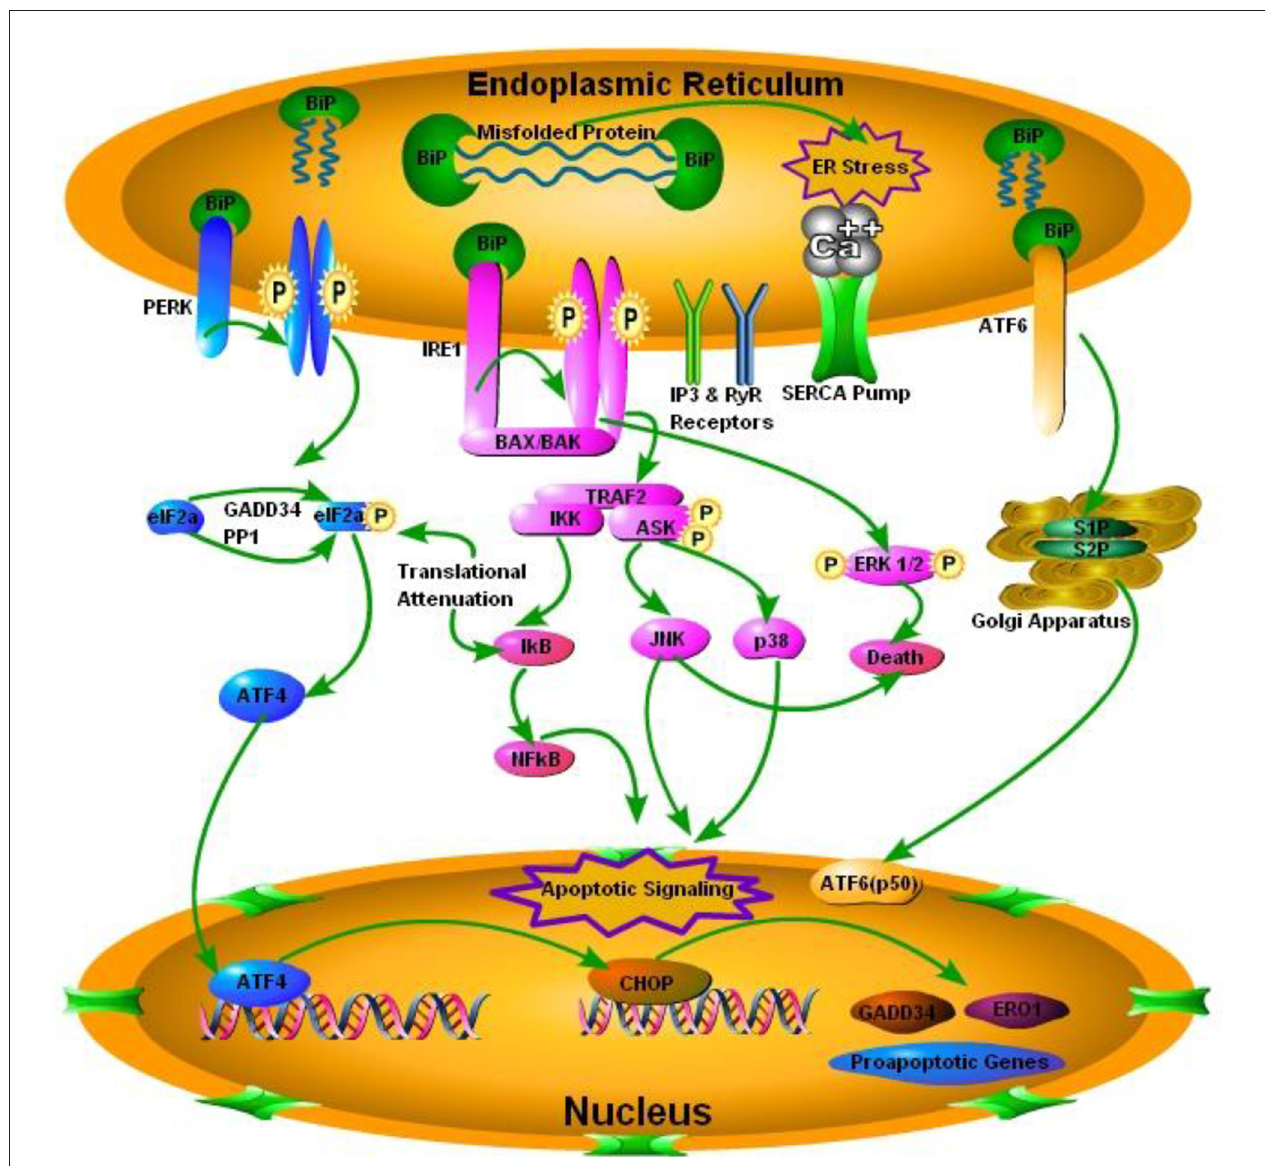
FIGURE 1 | Schematic presentation of the prion protein scrapie (PrP Sc ) accumulation and subsequent endoplasmic reticulum (ER) stress mediated activation of the iinositol requiring enzyme 1 (IRE1), double stranded RNA-activated protein kinase (PKR)-like ER kinase (PERK) and activating transcription factor 6 (ATF6). PERK pathway, through PERK phosphorylation and translation of initiation factor 2 (eIF2 α ) phosphorylation, inactivates eIF2 α and attenuates translation via activating transcription factor 4 (ATF4), which ultimately results in activation of C/EBP homologous protein (CHOP) and pro-apototic, growth arrest and DNA damage-inducible protein 34 (GADD34) and ER oxido-reductin 1 (ER01) genes. IRE1 pathway activates apoptotic signaling via BCL2-associated X protein (BAX) and BCL2 antagonist/killer (BAK). TNF receptor associated factor 2 (TRAF2), results in the activation of IkB kinase (IKK) and apoptosis signal regulating kinase (ASK), IKK through inhibitory kappa B (IkB) activates nuclear factor of kappa B (NFkB) and ultimately apoptotic signaling occurs. On the other hand ASK phosphorylation results in the activation of c-Jun NH2-terminal protein kinase (JNK) and p38 pathway of mitogen activated protein kinase (MAPK) pathways. Phosphorylation of extracellular signal-regulated kinases 1 and 2 (ERK1/2) results in death via conjunction with JNK. Activating Transcription factor 6 (ATF6) pathway via site 1 and site 2 proteases (S1P and S2P) activates transcription factor p50 in